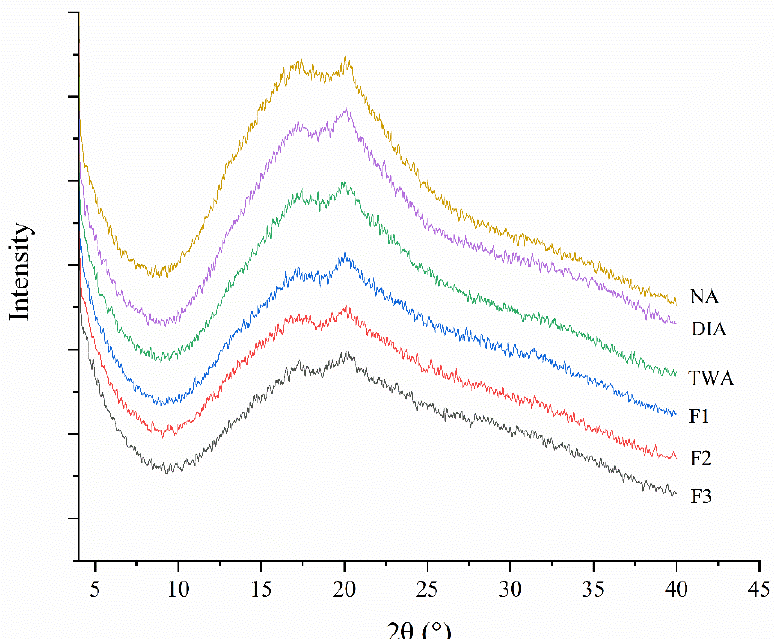
Figure 5. X-ray diffraction spectra of the steamed cold noodles that were not colored (NA), colored with deionized water-dissolved BRA (DIA), colored with tap water-dissolved BRA (TWA), and colored with tap water-dissolved BRA containing the three optimized chelator formulations (F1 – F3).